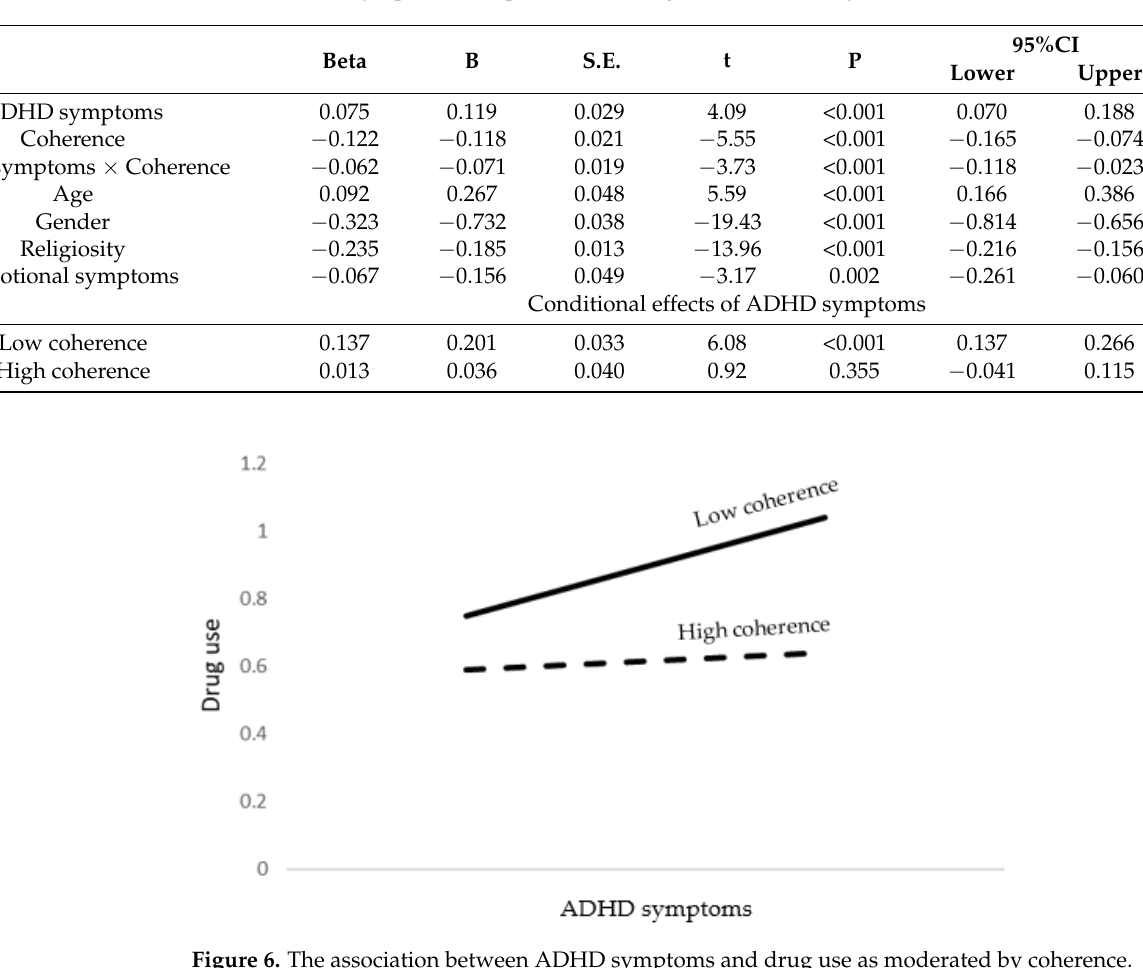
Figure 6. The association between ADHD symptoms and drug use as moderated by coherence.